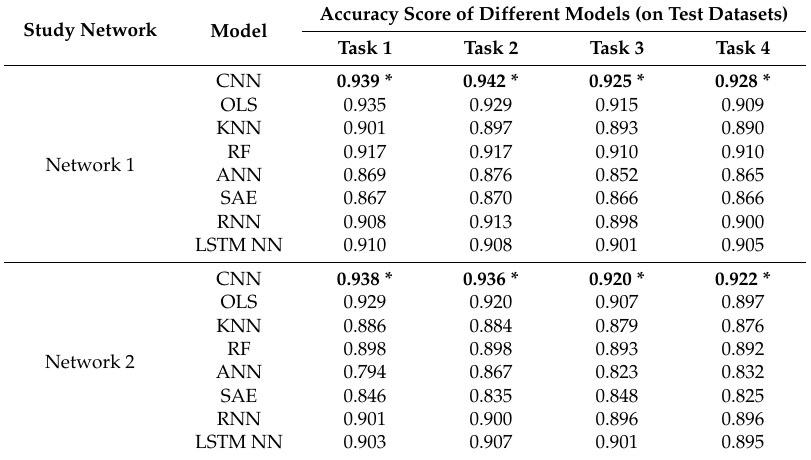
Figure 6. Results of different algorithms: ( a ) MSEs on Network 1; and ( b ) MSEs on Network 2.